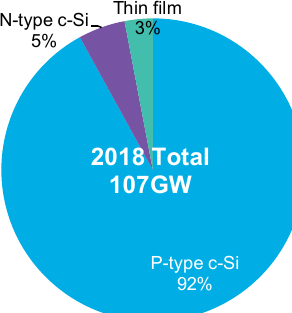
Figure 14. 2018 global PV module shipment by product type.